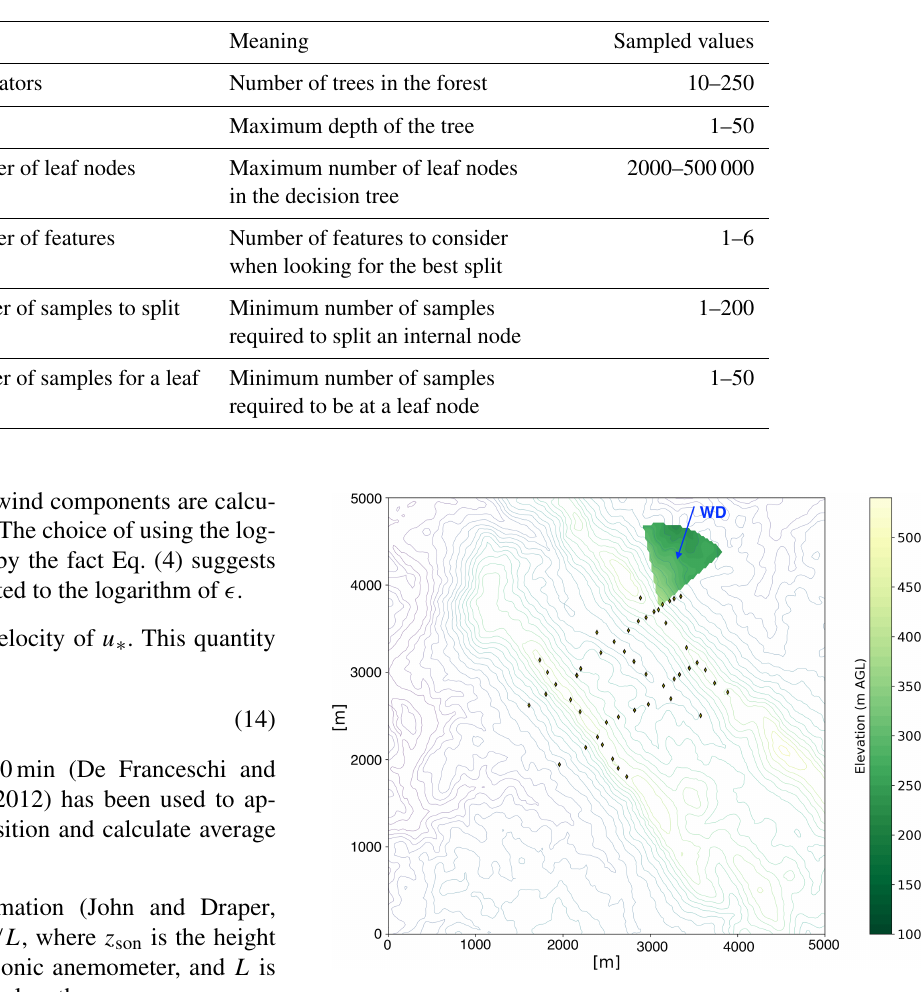
Table 2. Hyperparameters considered for the random forest algorithm.